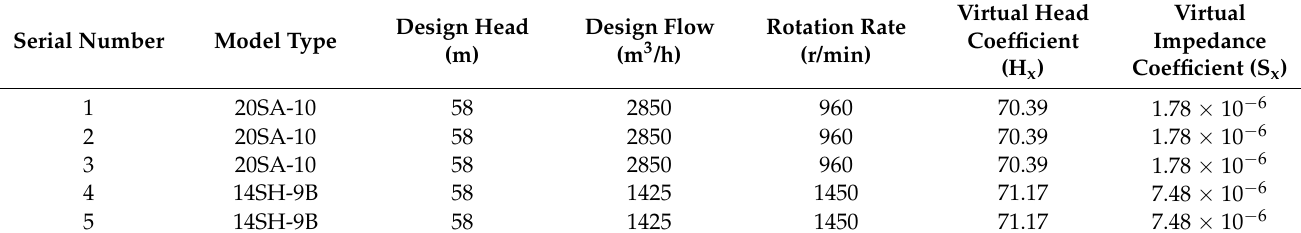
Table 3. Design parameters and characteristics of the pump unit.